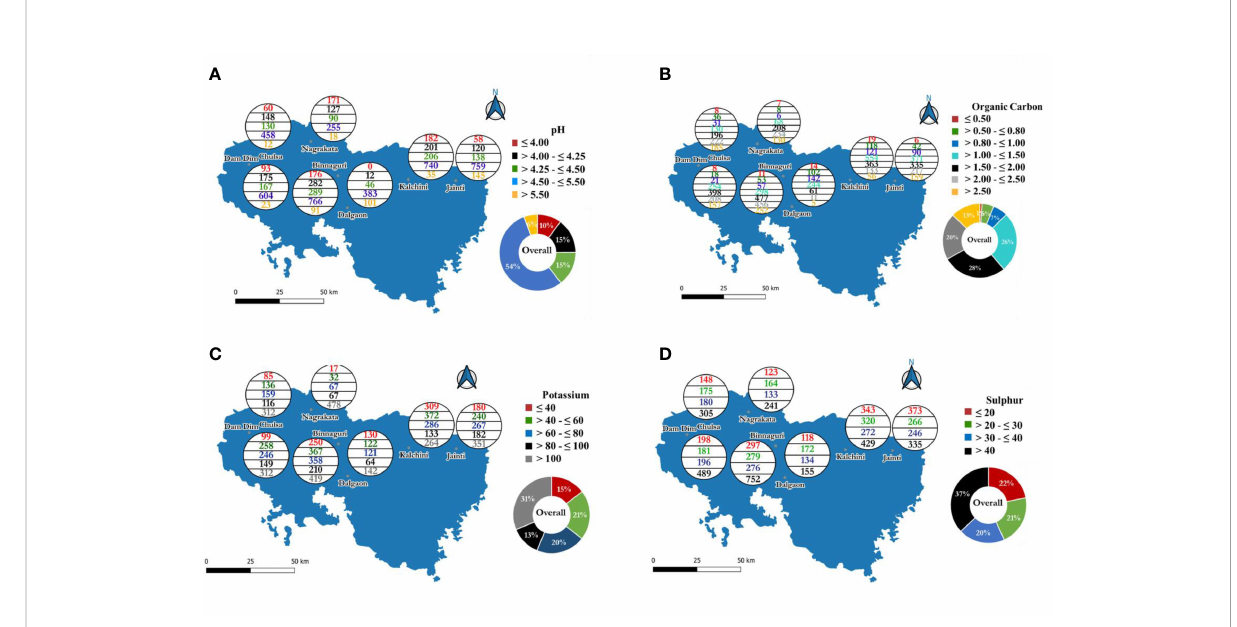
FIGURE 2 Distribution pattern of7300 analyzed soil samples collected from seven sub-districts in the tea growing region of Dooars, West Bengal, India based on different ranges of reported soil parameters: (A) pH, (B) organic carbon, (C) available potassium and (D) available sulphur.